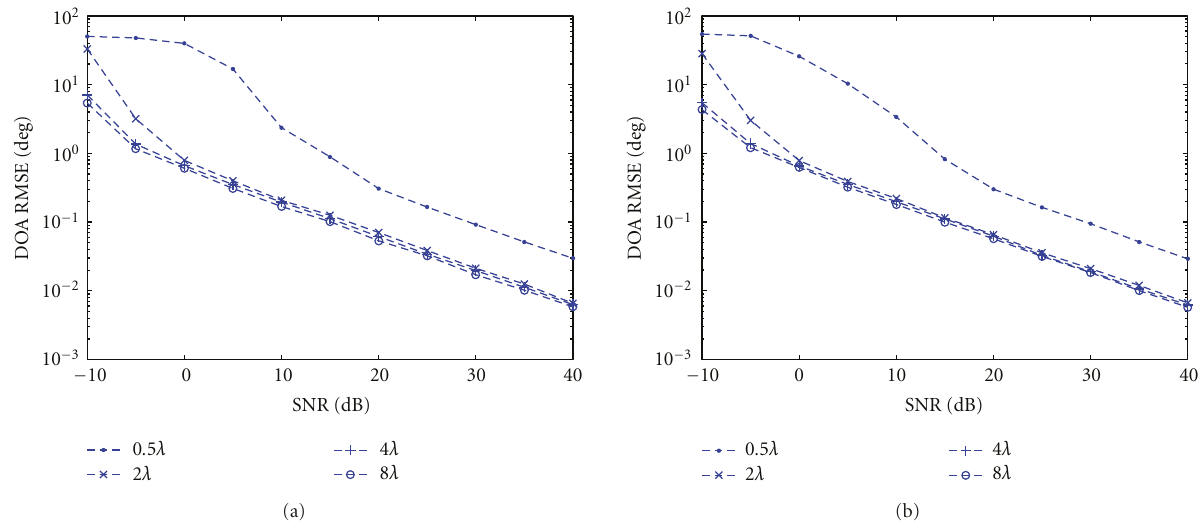
Figure 1: DOA estimates RMSE of the proposed EVSA-PM against SNRs. (a) Source 1, (b) source